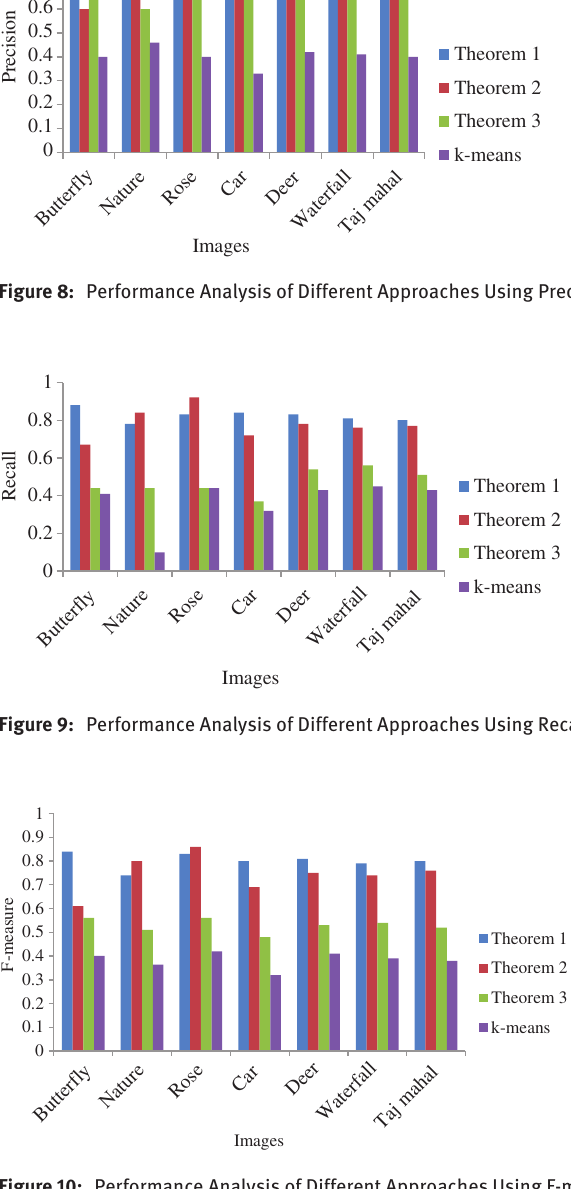
Figure 10: Performance Analysis of Different Approaches Using F-measure.